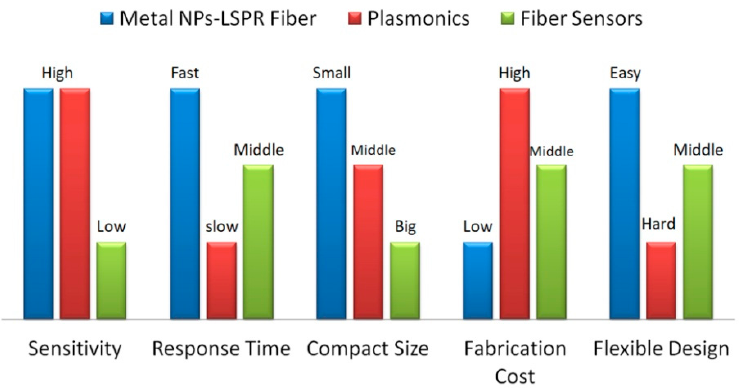
Figure 7. Properties comparison for metal NPs based LSPR fiber sensors, plasmonics devices and fiber sensors.